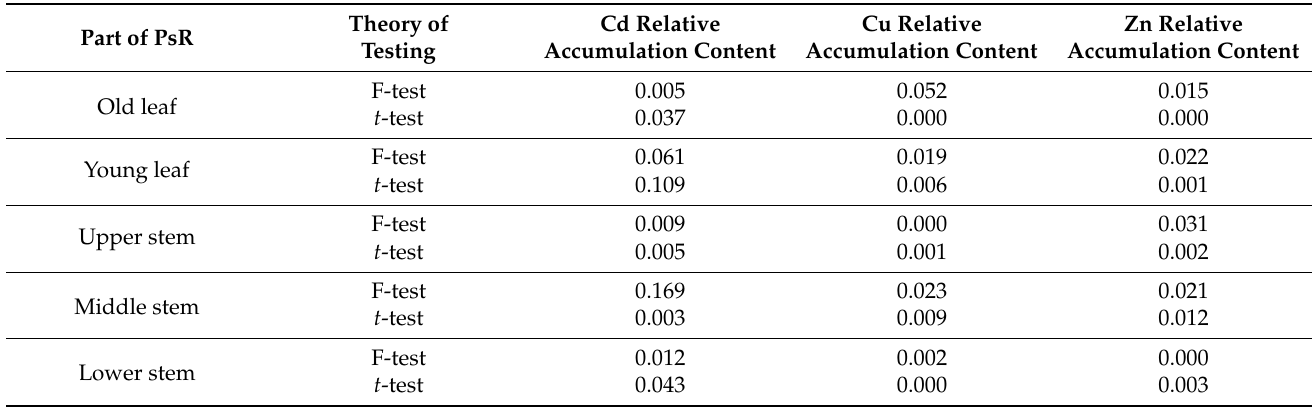
Table 1. A significant difference in heavy metal relative accumulation in Pennissimus arundinacea under dry and fresh leaves ( p ).